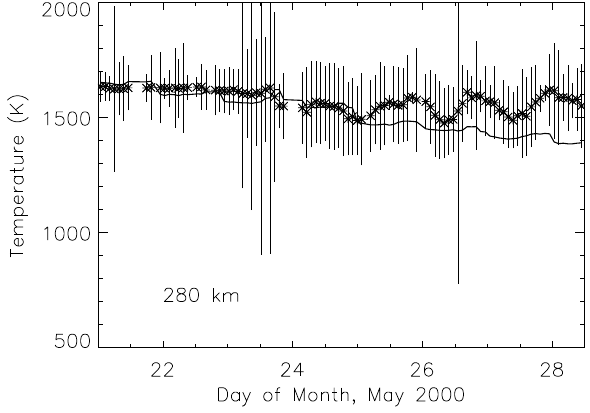
Fig. 6. Thermospheric neutral temperature derived from inversion of the emission intensity profiles in Fig.